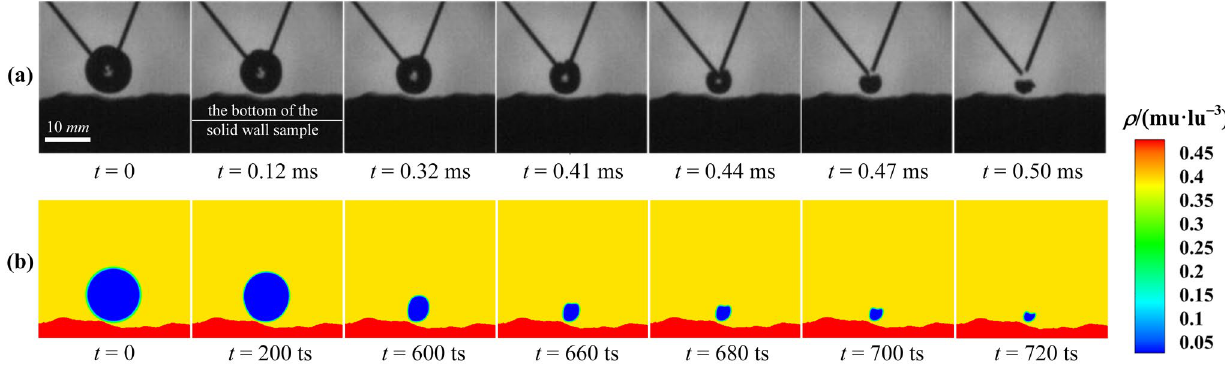
Figure 4. Comparison of the profile evolutions of the collapsing bubble between ( a ) the experiments ( λ ≈ 1.6, R 0 = 5 mm) and ( b ) LBM simulations ( λ = 1.6, R 0 = 50 lu).